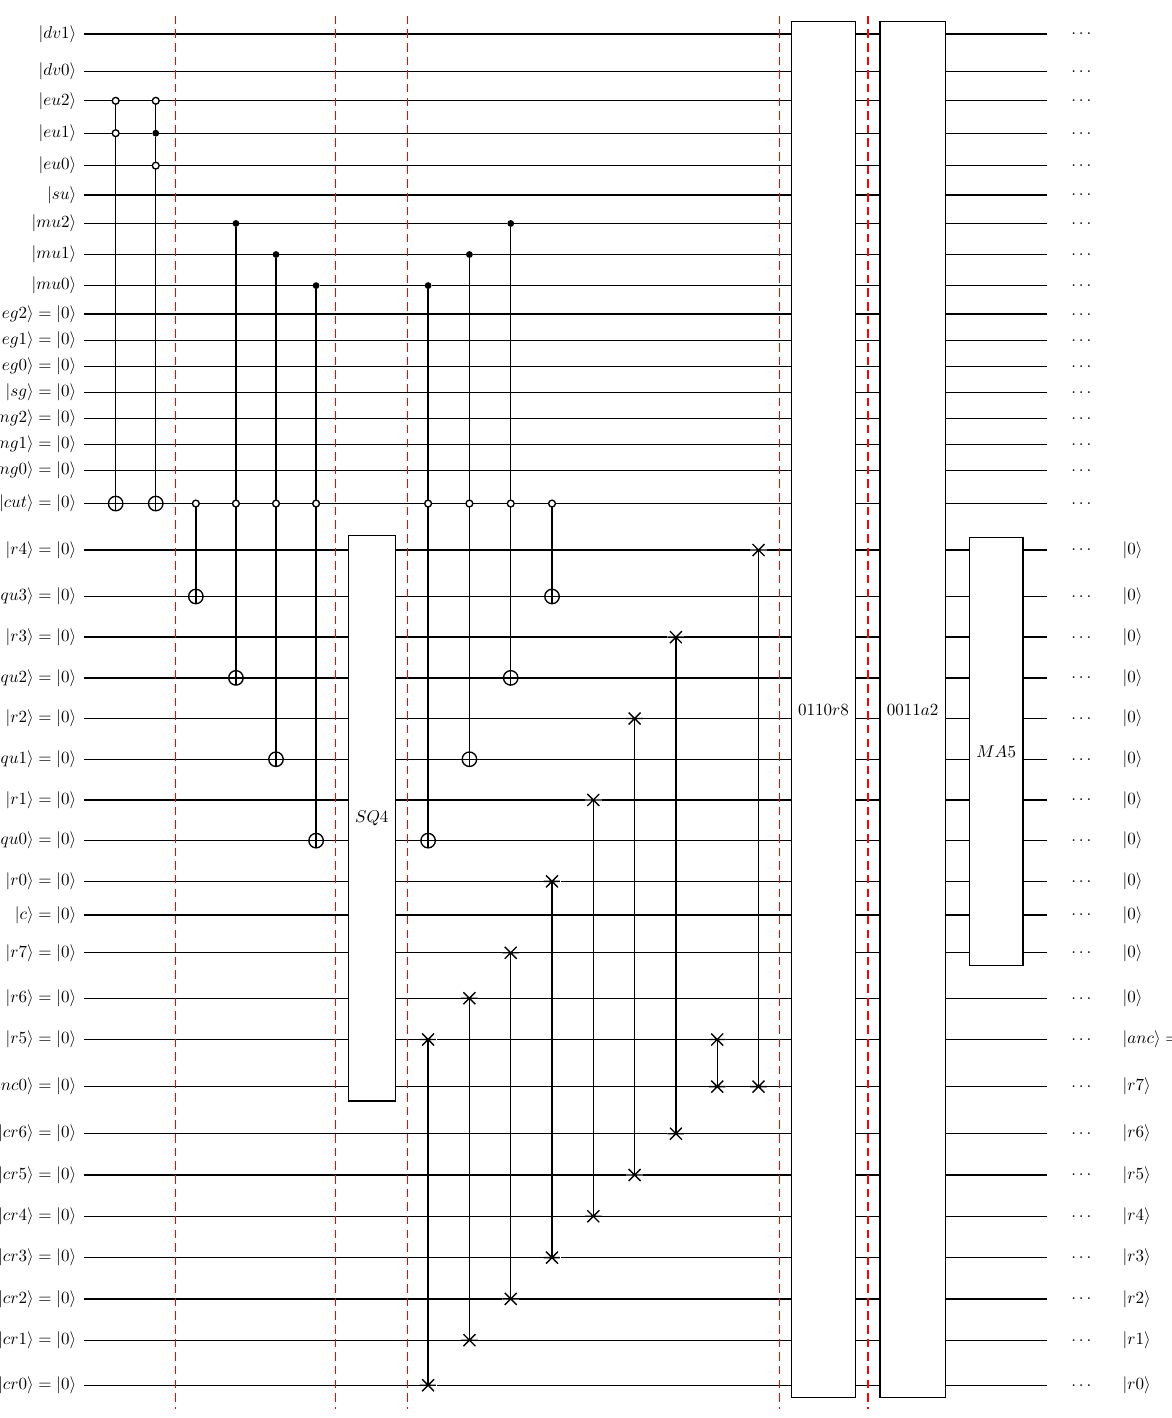
Figure 3. Modified D1Q3 model: quantum circuit design for computing (cid:126) g eq . Floating-point represen- tation uses four mantissa qubits ( N M = 4) and three exponent qubits ( N E = 3), with an exponent bias set to eight. Part